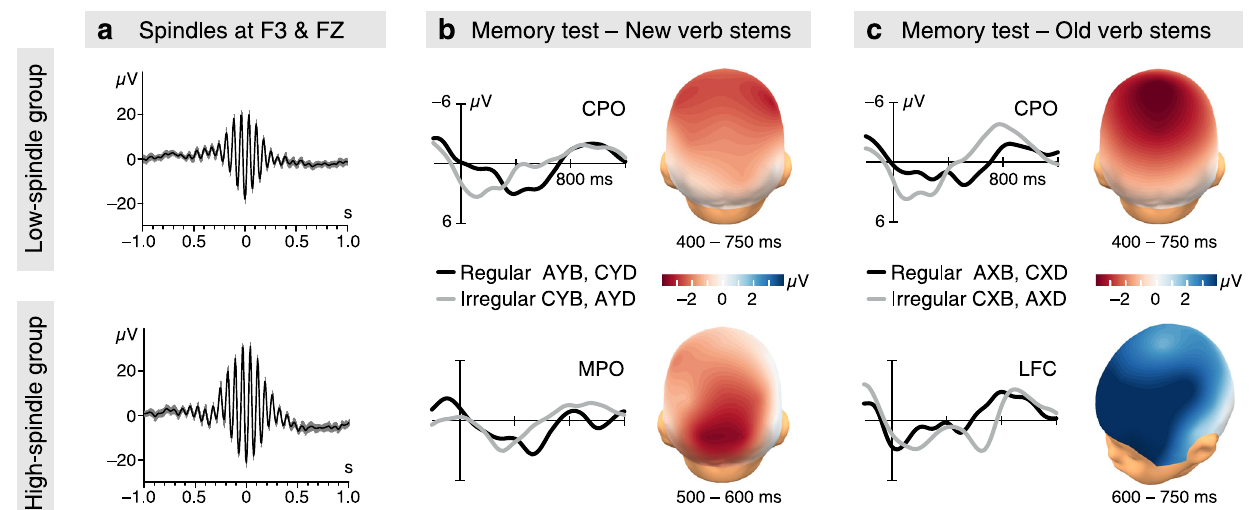
Fig. 3 | Frontal sleep spindles and mid-latency memory effects in the spindle subgroups. a Fast sleep spindles (mean±SEM) during NonREM sleep of the post- encoding naprecorded overthe leftfrontal(F3)and mid-frontal(FZ) brain regions in the two spindle subgroups, with mean peak-to-peak amplitudes of 35.83 µ V (SD=4.64) in the low-spindle subgroup ( N =24 infants) and 51.86 µ V (SD=6.86) in thehigh-spindlesubgroup( N =24infants).Forspindlenumberandspindledensity, see Supplementary Table 4. b ERPs from suf fi xes in regular (black lines) and irre- gular (grey lines) NAD phrases with new verb stems and the N400-like